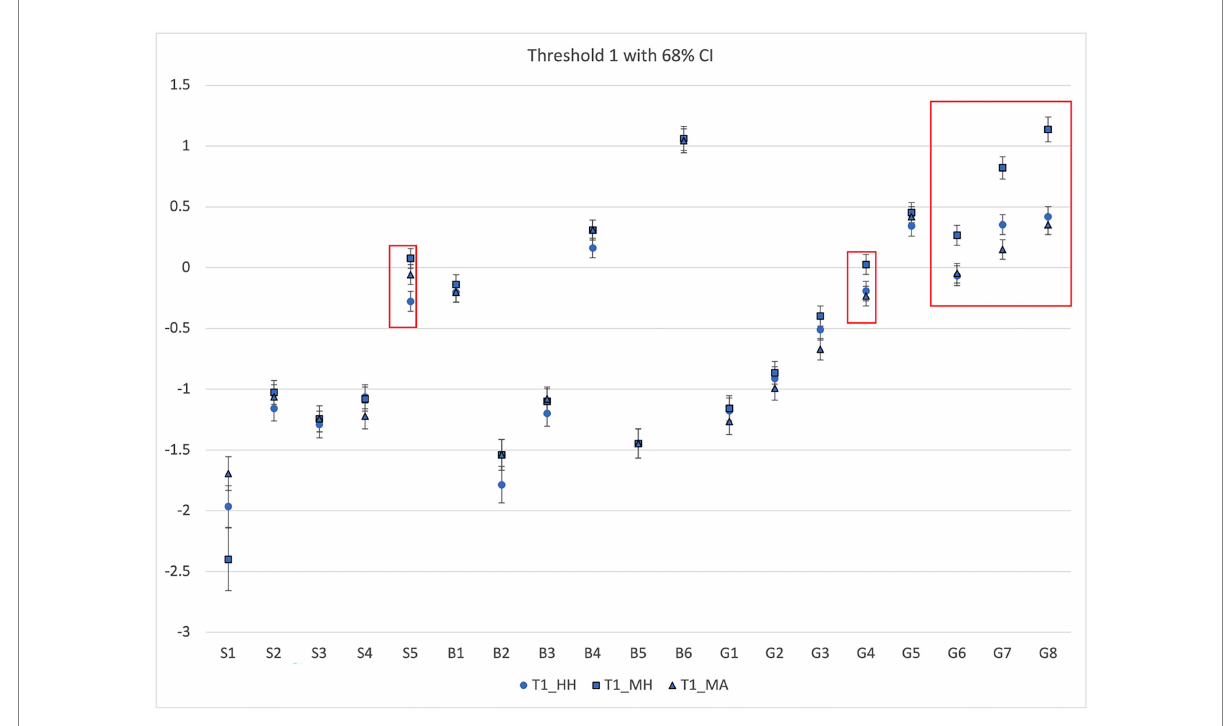
FIGURE 3 CFA Threshold 1 with 68% CI for the HH, MA, and MH scoring